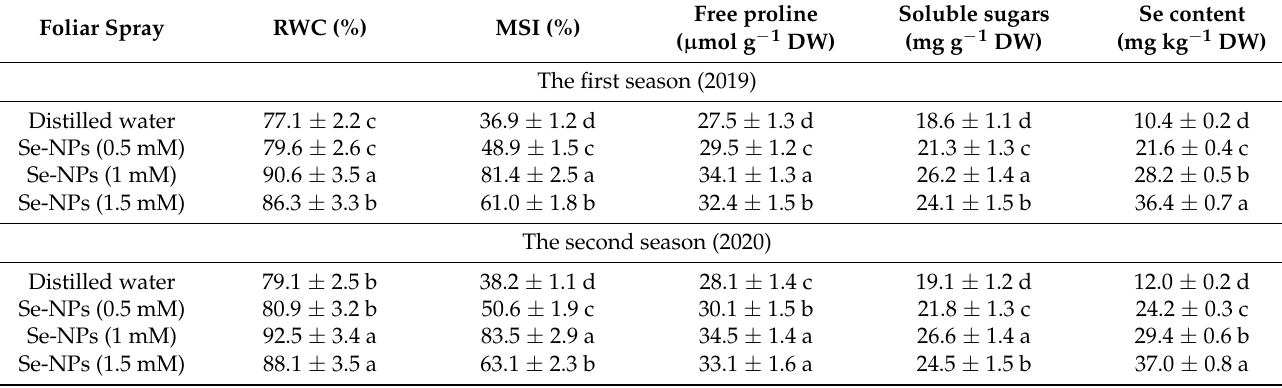
Table 5. Tissue cell integrity response of salt-stressed common bean plants (soil EC = 7.55–7.61 dS m − 1 ) to foliar nourishment with selenium dioxide nanoparticles (Se-NPs) in two consecutive